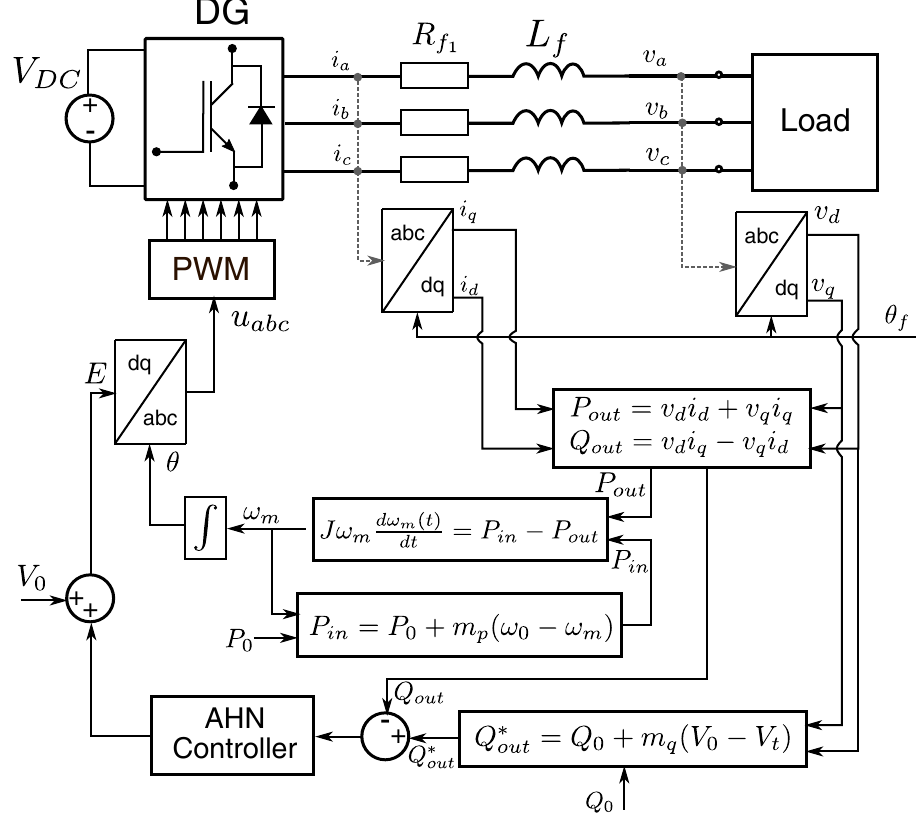
Figure 3. Diagram of the robust control scheme using an artificial hydrocarbon network